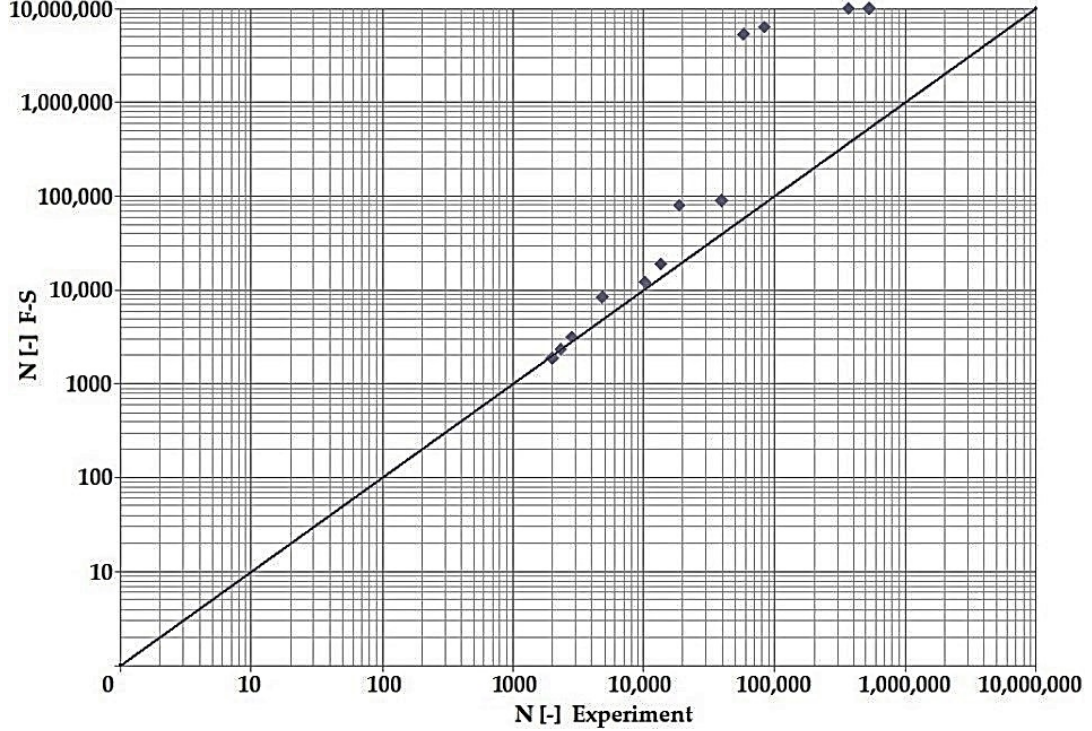
Figure 26. Dependence of theoretical and experimentally obtained number of cycles, F–S vs. experiment, phase shift 90°.